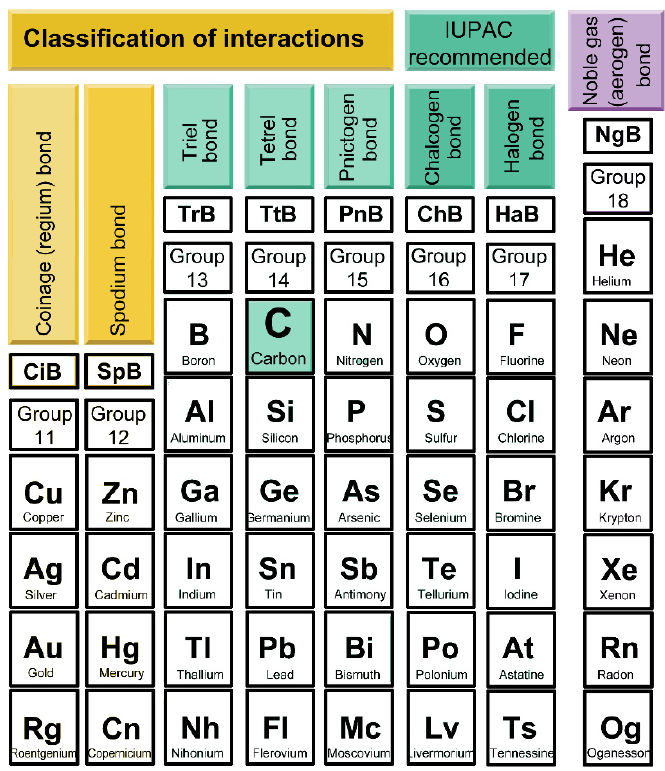
Figure 1. Names used to refer to the interactions where groups 11 to 18 act as Lewis acids.